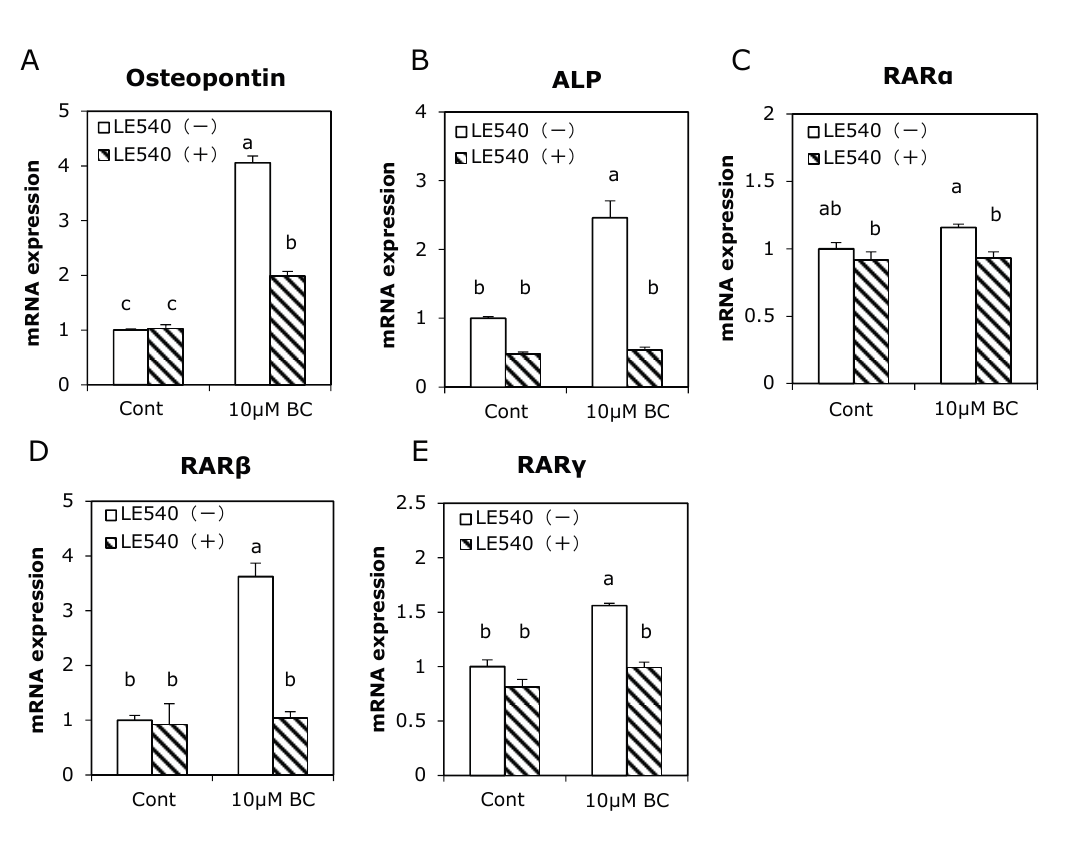
Figure 5. Effect of RAR antagonist on enhanced osteoblast-related gene expression with β -carotene in MC3T3-E1 cells. Cells were precultured in α -MEM/10% FBS for 24 h and subsequently cultured in medium with 10% charcoal-treated FBS containing 10 μ M of β -carotene (BC) with (hatched bars) or without (open bars) 10 μ M of RAR antagonist LE540 for one day. Figure shows the ratio of osteopontin ( A ), ALP ( B ), RAR α ( C ), RAR β ( D ), and RAR γ ( E ) mRNA levels relative to control without LE540. Data are expressed as means ± SEM ( n = 3). Different letters indicate significant differences ( p < 0.05). Data are from representative